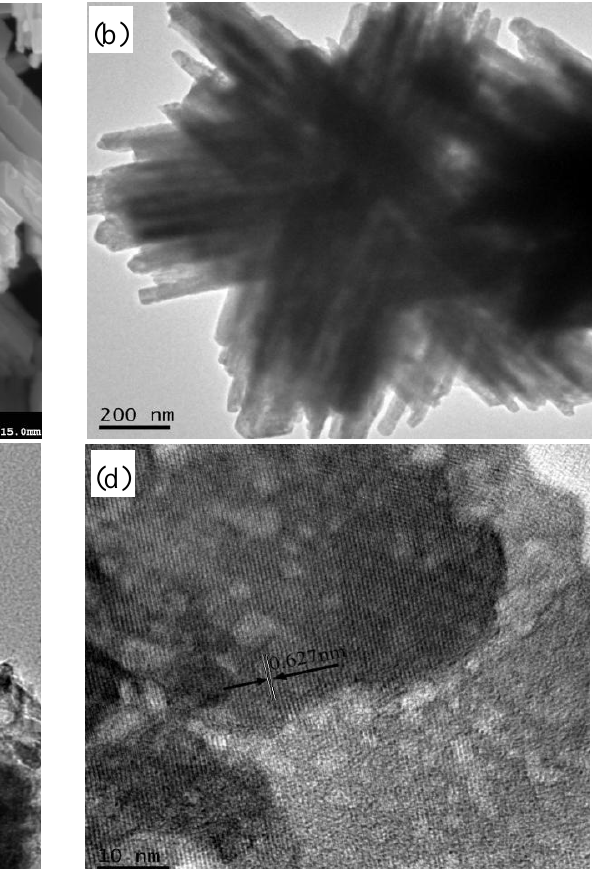
synthesized via 3